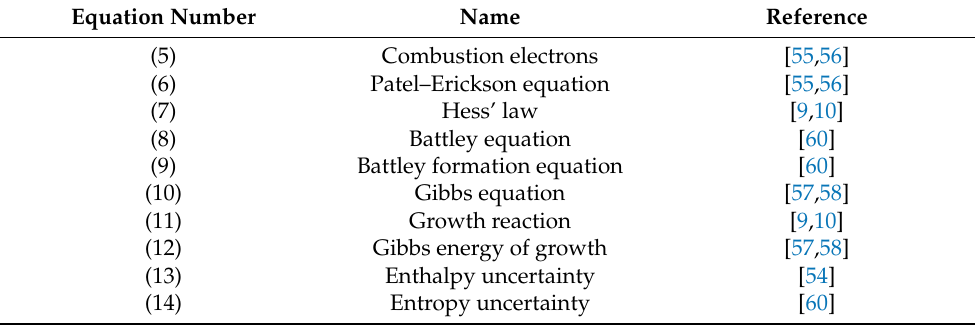
Table 3. Equations used for finding the thermodynamic properties of viruses. Symbols: E —number of electrons transferred to oxygen during complete combustion; n J —number of atoms of element J in the empirical formula of live matter; ∆ C H 0 —standard enthalpy of combustion; ∆ f H 0 ( Bio )—standard en- thalpy of formation of live matter; S 0 m ( Bio )—standard molar entropy of live matter; S 0 m ( J )—standard molar entropy of element J ; a J —number of atoms per molecule of element J in its standard state elemental form ( a C = a P = a S = 1 for carbon, phosphorus and sulfur, but a H = a N = a O = 2 for hydrogen, nitrogen and oxygen diatomic molecules [57,58]); ∆ f S 0 ( bio )—standard entropy of formation of live matter; ∆ f G 0 ( Bio )—standard Gibbs energy of formation of live matter; CH 1 . 7978 O 0 . 4831 N 0 . 2247 S 0 . 0225 — equimolar mixture of amino acids; (Bio)—virions (virus live matter), represented by an empirical formula CH nH O nO N nN P nP S nS ; ∆ r G 0 —Gibbs energy of growth; ν —stoichiometric coefficient. The stoichiometric coefficients for the growth reaction (11) differ between viruses and can be found in the Supplementary Material (Table